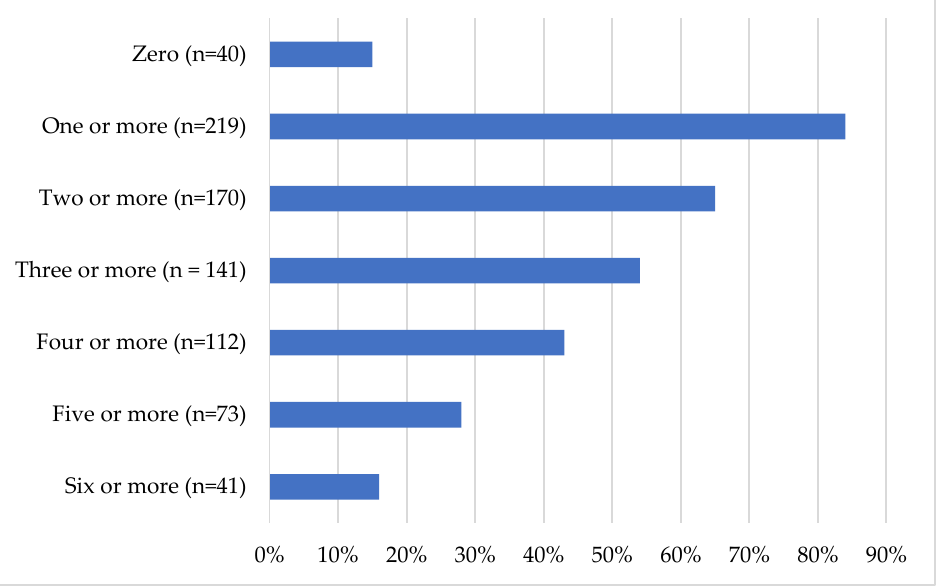
SR), social anxiety disorder (SIAS-6/SPS-6 or SIPS), anger (DAR-5), alcohol use